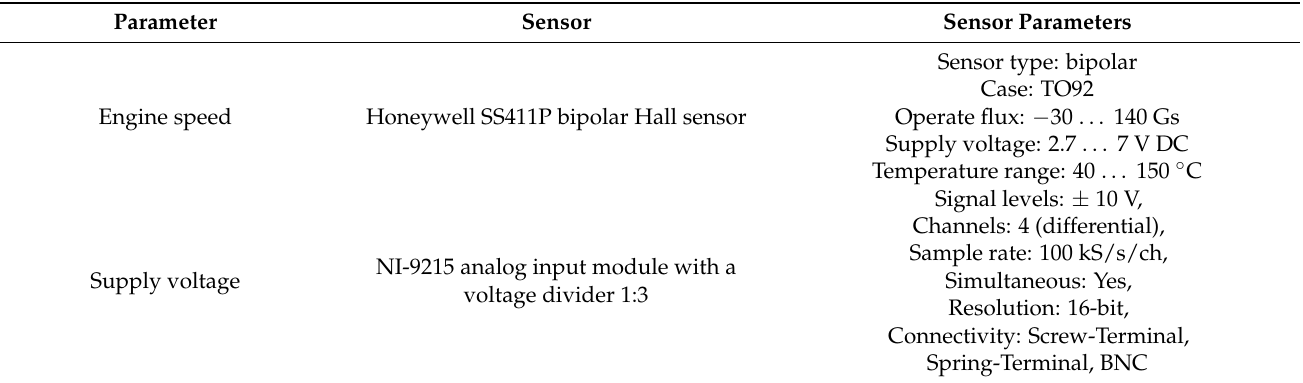
Figure 5. Diagram of the developed control and measurement system. Table 1. List of the measured parameters and used sensors.